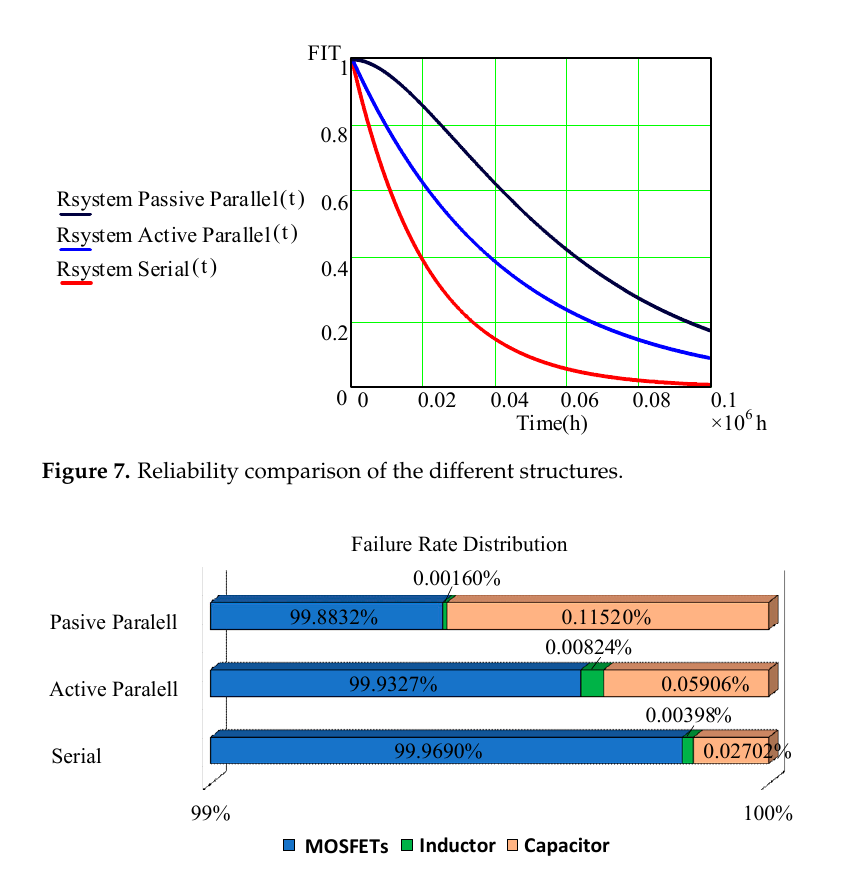
Figure 8. Failure rate distribution of di ff erent components.